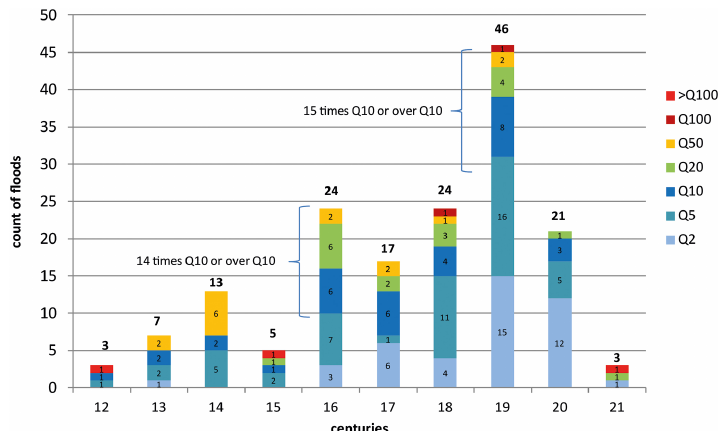
Figure 2. Frequency of floods in Prague over the centuries.